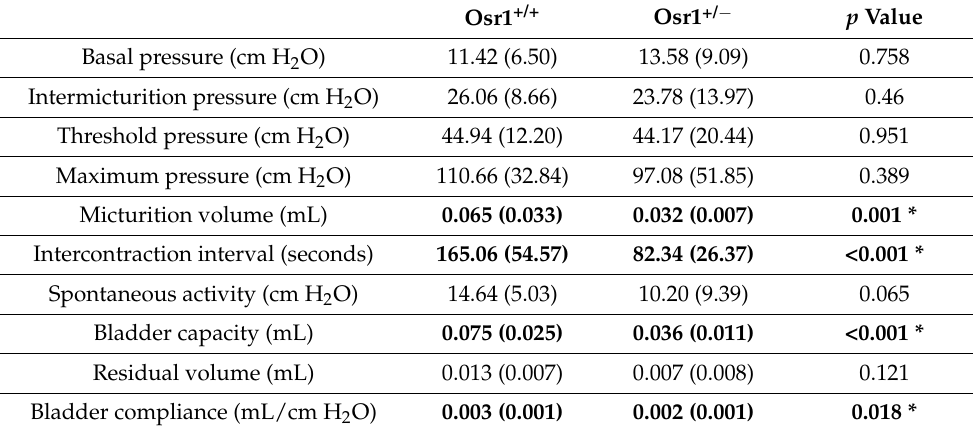
Table 1. Comparison between cystometry parameters in the Osr1+/+ and Osr1 +/ − mice.